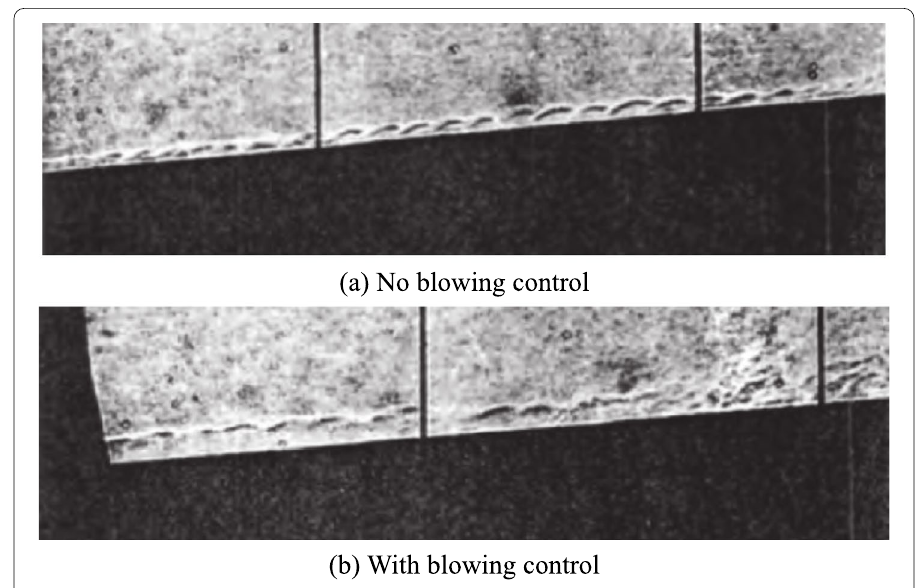
Fig. 17 Schlieren diagram of secondary modal instability of conical boundary layer at zero angle of attack [97]. a No blowing control. b With blowing